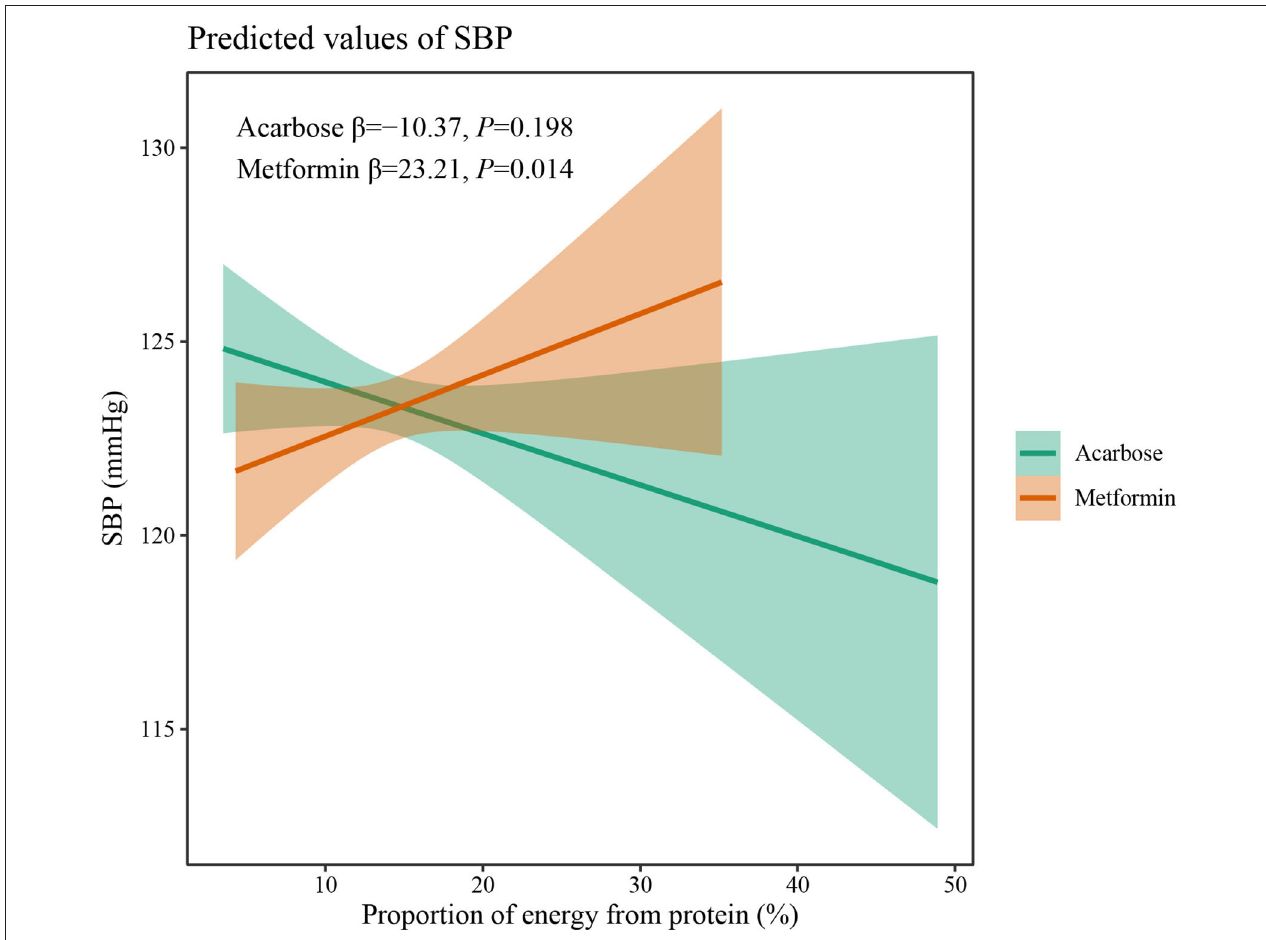
FIGURE 6 | Differential associations between proportion of energy from protein intake and SBP in metformin and acarbose groups. The β value adjusted for age, sex, time of intervention, and duration of